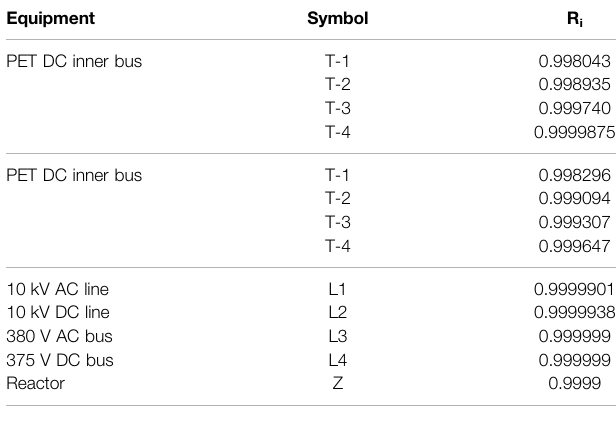
TABLE 1 | Power supply reliability parameter of different modules in PET.